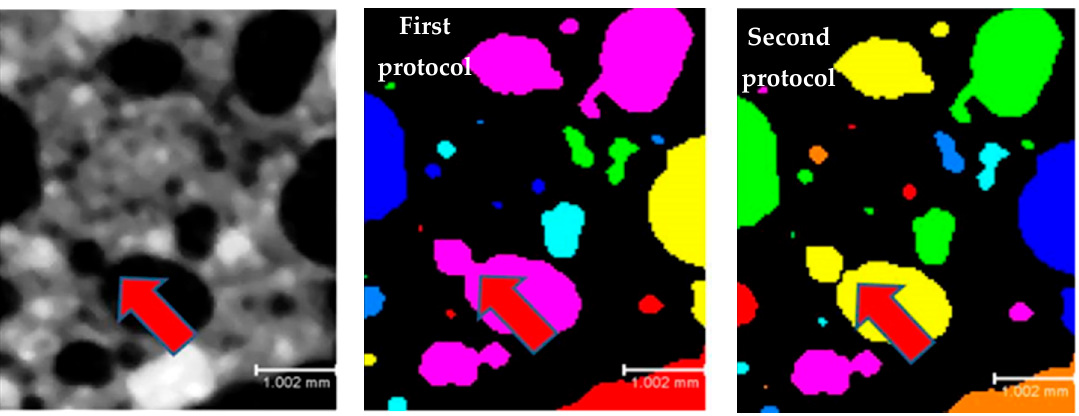
Figure 4. Numbers of pores measuring protocols.